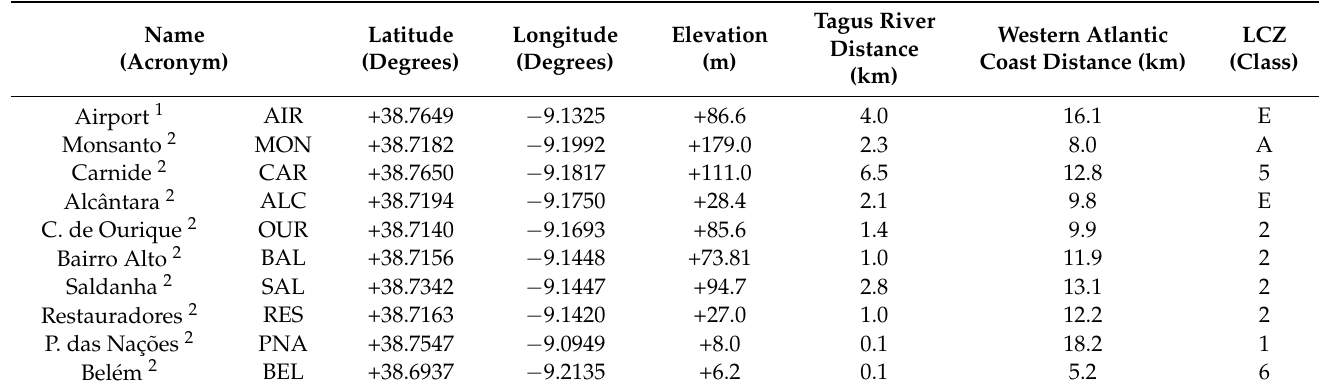
Table 1. List and characterization of the measurement sites